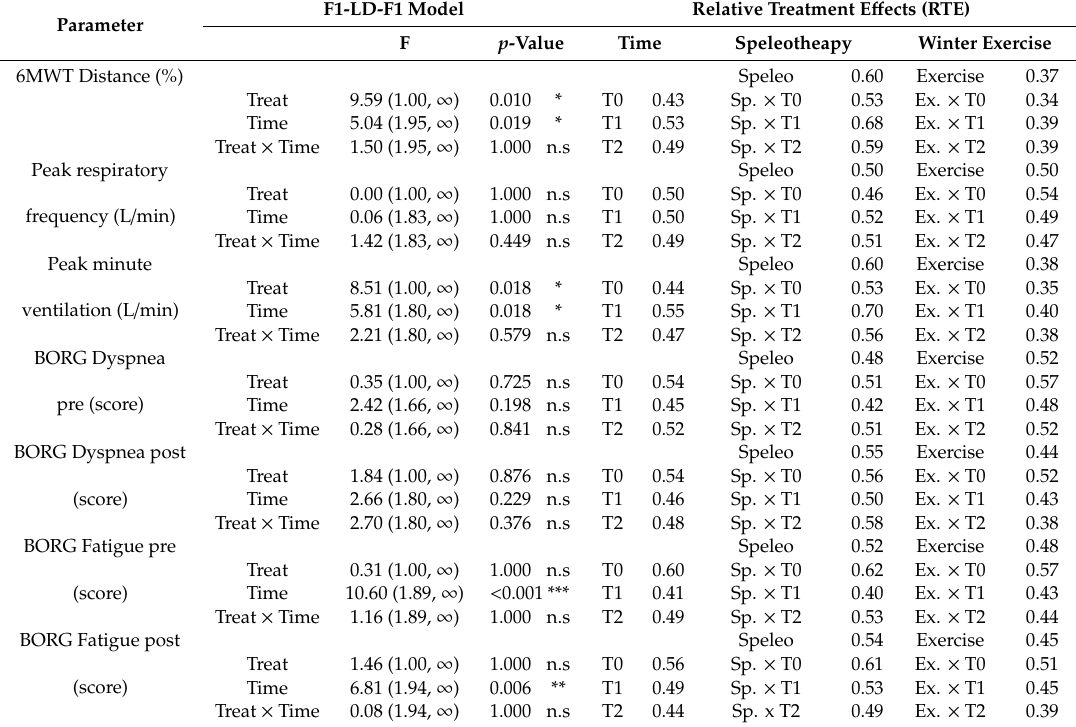
Table 4. Results from the F1-LD-F1 model reporting time, treatment, and interaction e ff ects.